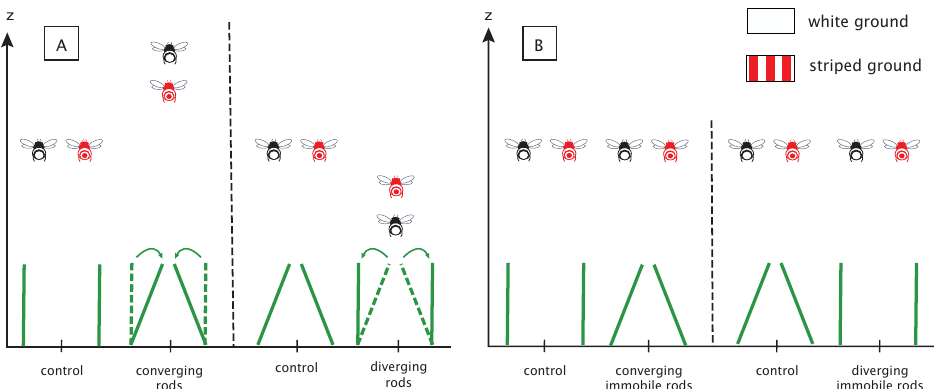
Figure 5. Predictive altitude of bees undergoing SARC or splay angle manipulations inside the flight tunnel. ( A ) Predictive altitude of bees during dynamic manipulations of SARC (experiment 1). ( B ) Predictive altitude of bees during static manipulations of splay angle (experiment 2). Red bees represent bees flying above striped ground and black and white ones represent bees flying above white ground. Immobile rods are the control